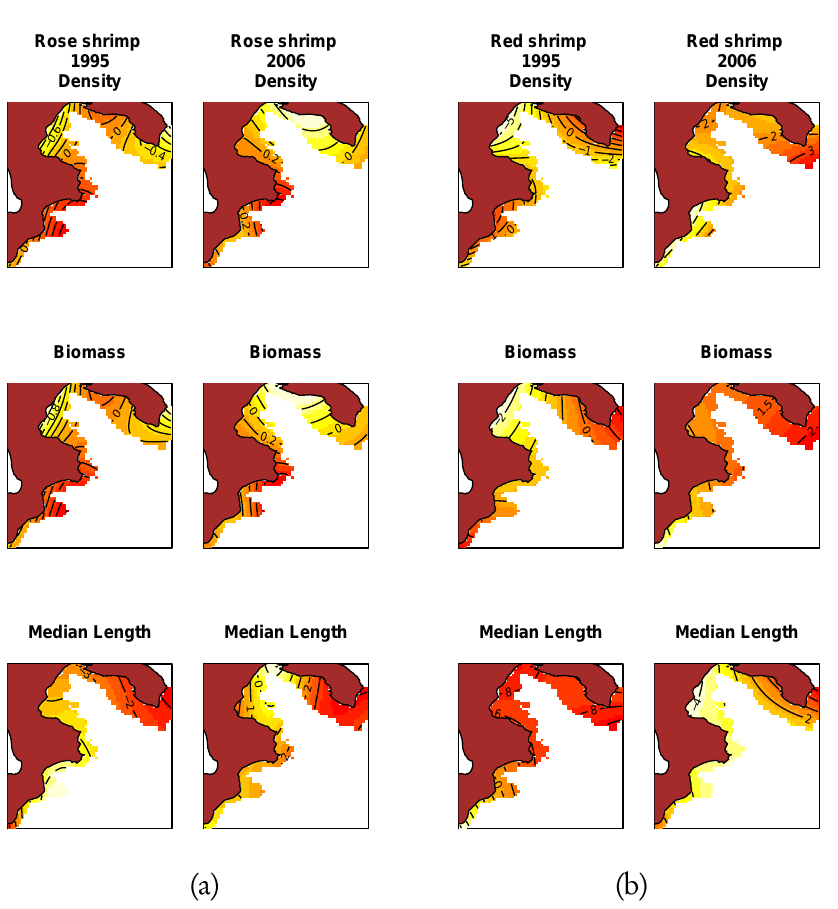
Figure 2 – Spatio-temporal smooth components of the fitted GAMs for years 1995 and 2006. (a) P. Longirostris , (b) A. Foliacea . The yellow coloured areas correspond to lower values of species density, biomass and median carapace length. In reverse, the warm colours indicate areas charac- terized by higher values of the population variables for the two